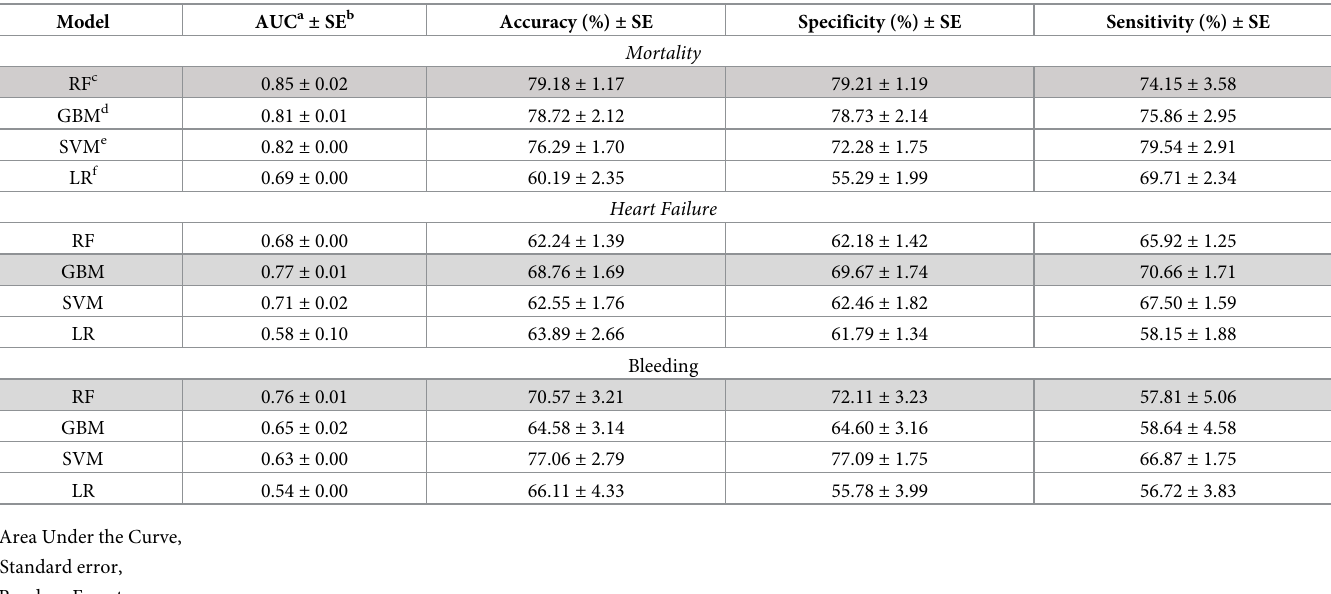
Table 2. Cross-validation summary results for GBM, RF and SVM models. Model